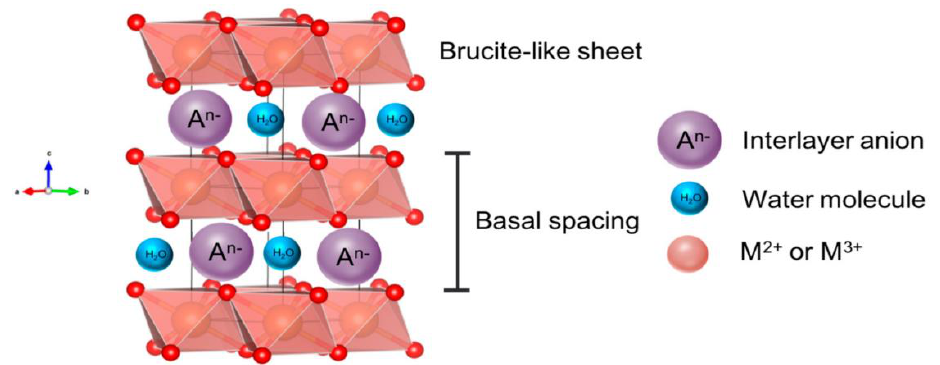
Figure 1. Diagram showing the structure of layered double hydroxide “Ref.[4]” .